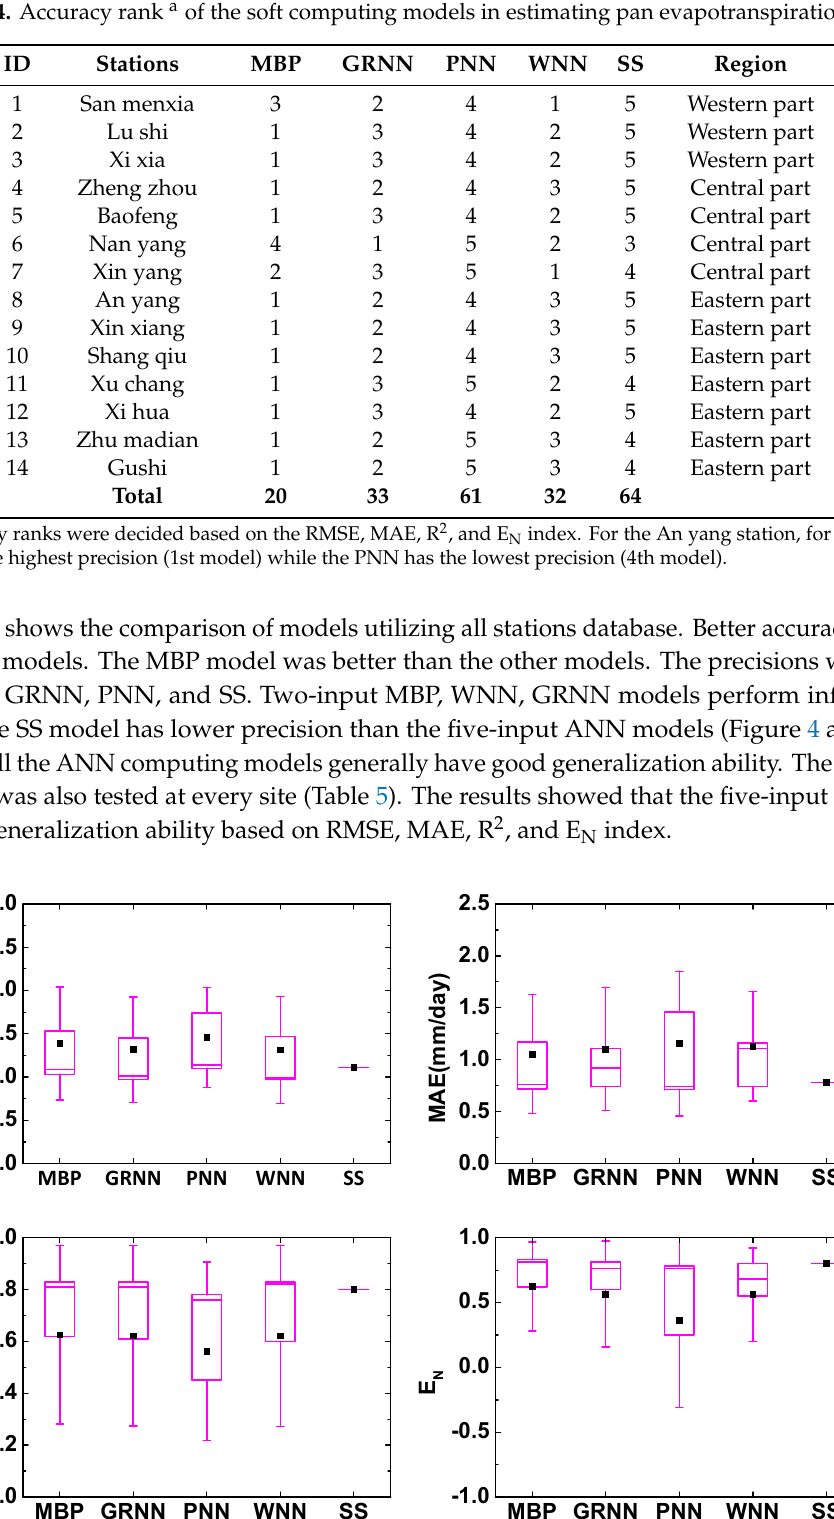
Table 4. Accuracy rank a of the soft computing models in estimating pan evapotranspiration (E).